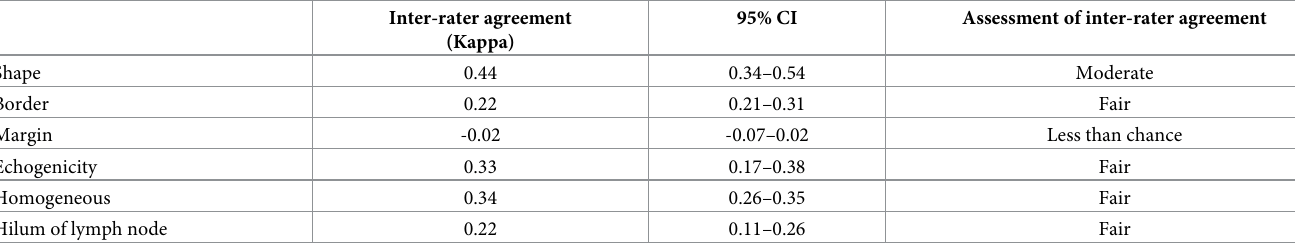
Table 3. Inter-rater agreement of EUS features in 68 lymphadenopathies.